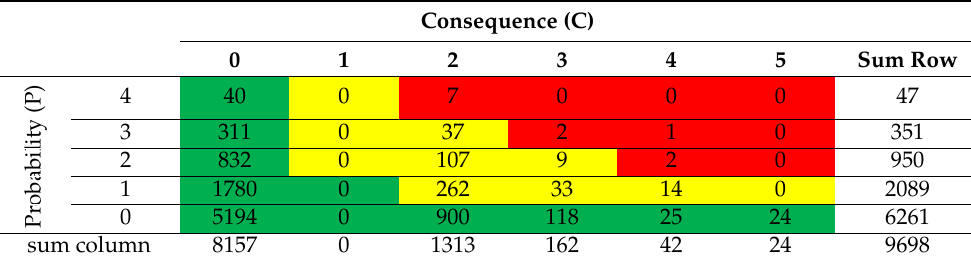
Table A2. Risk matrix based on LCI only at time 17.00.